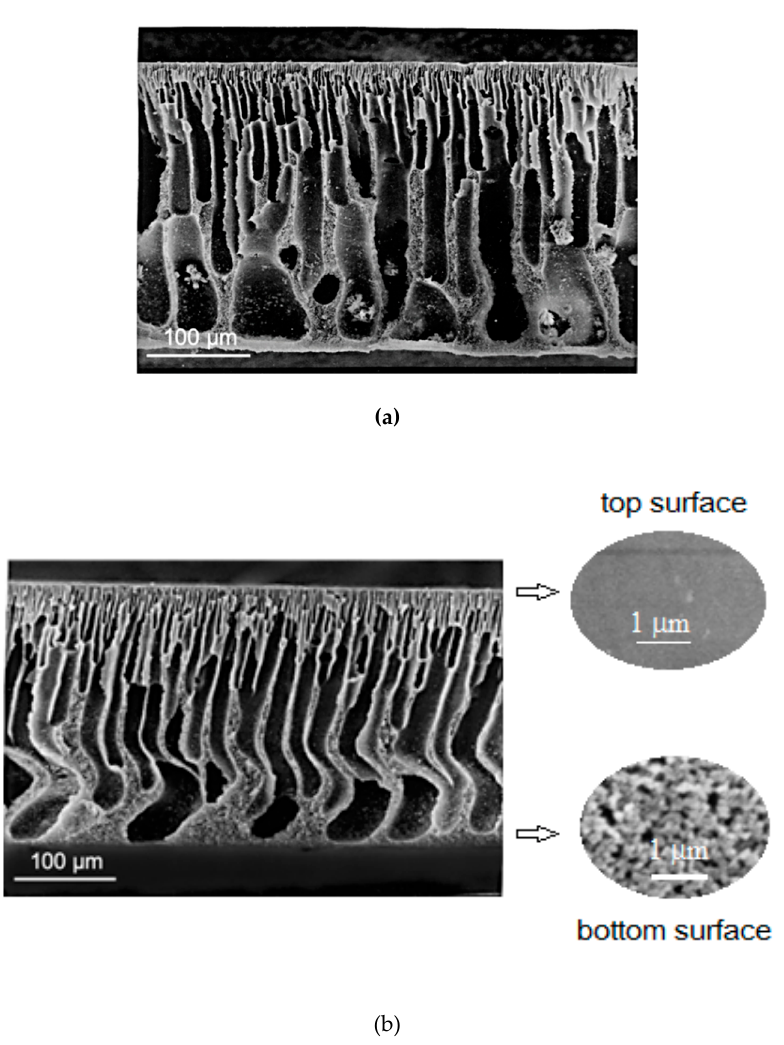
Figure 5. SEM micrographs of membrane cross-section: ( a ) co-PAA, and ( b ) co-PBOI with a detailed view of the top and bottom surfaces. Table 2. Mechanical and thermal properties of asymmetric